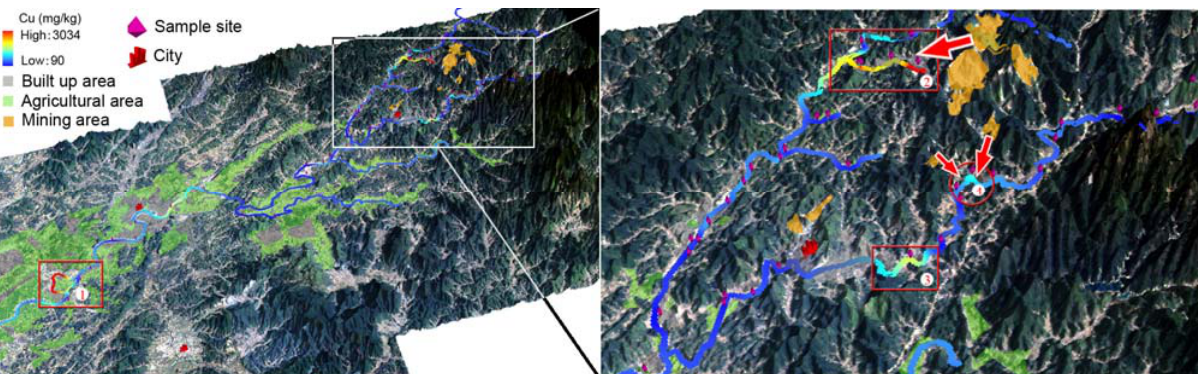
Figure 5. Maps showing the distribution of total Cu content in the soil along the Le’an River and its branches (left), and in the soil around mining area